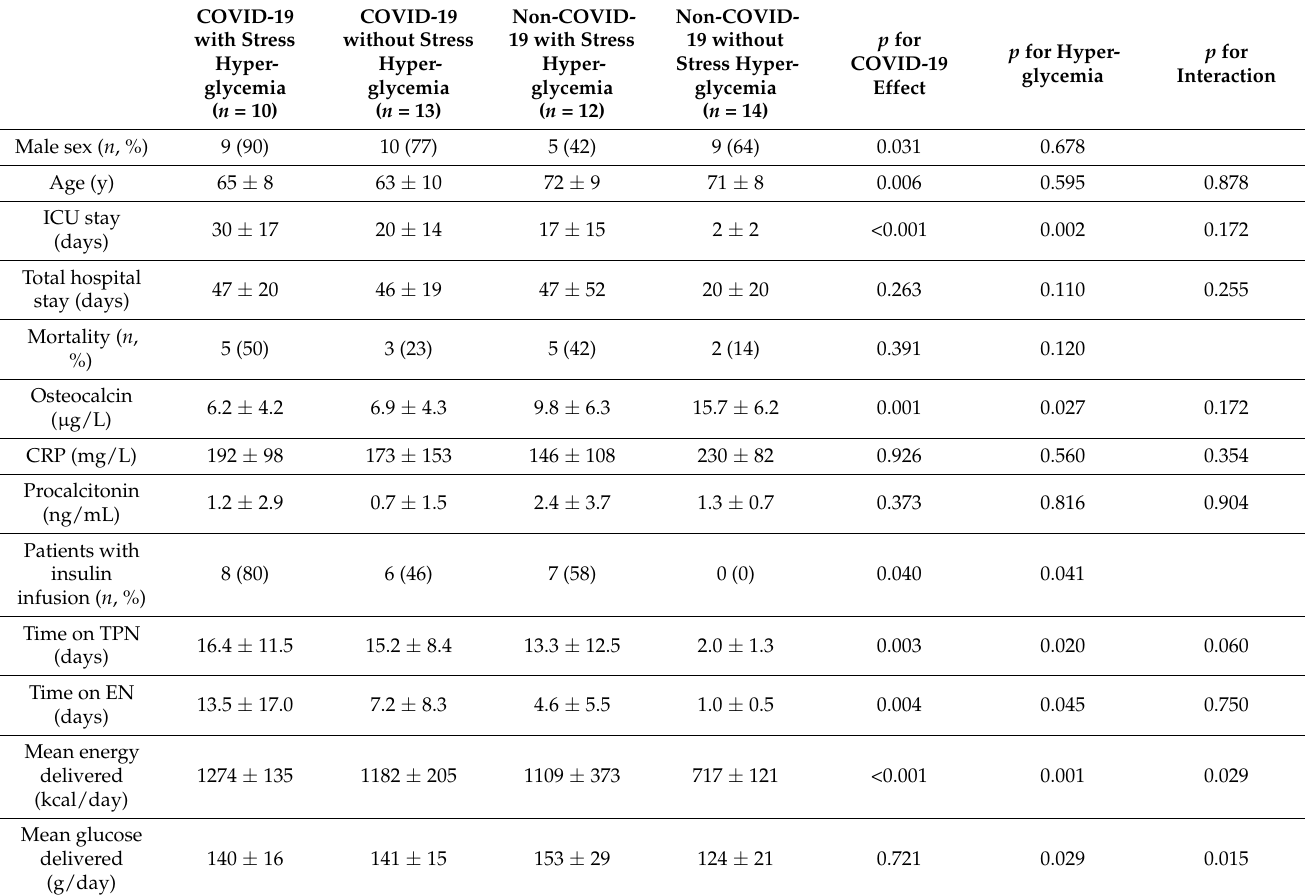
Table 3. Prognosis and serum markers of patients with and without COVID-19 and with or without stress hyperglycemia *, † .